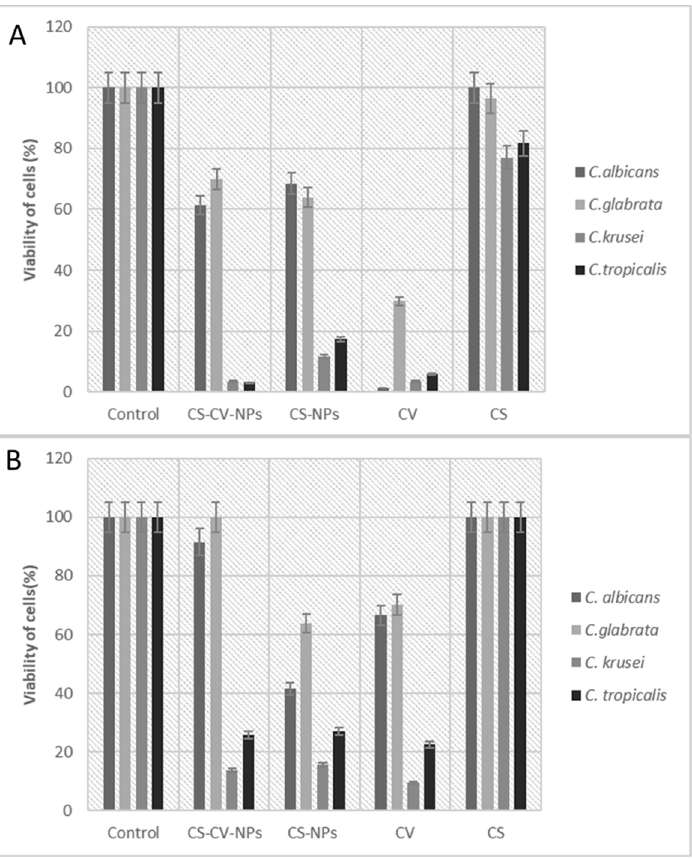
Figure 5. Cell viability expressed as % of XTT reaction product read at 490 nm. ( A ) NPs added at beginning of biofilm formation, ( B ) NPs added on preformed biofilm. Treated cells were compared to the control (one-way ANOVA followed by Dunnett’s post hoc test, p < 0.05).